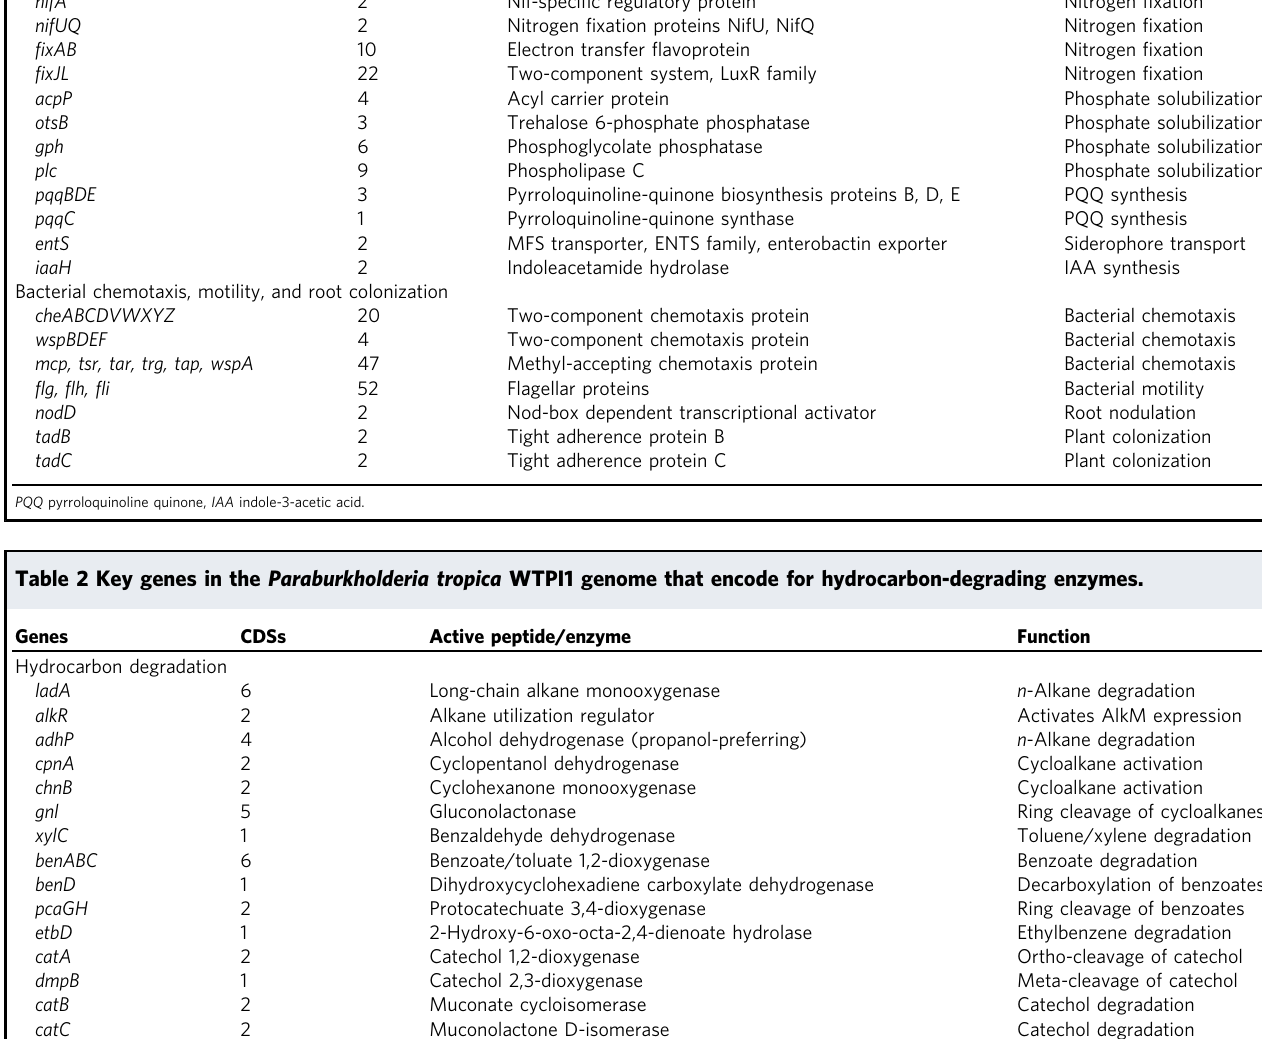
( p < 0.001) from that of the uninoculated plants (3.38 ± 0.07 g) (Fig. 1b). Statistical analysis of growth, in terms of mean shoot height per time, revealed that the inoculated M. sativa plants exhibited greater relative growth rate (0.109 ± 0.002 cm/day at the point of in fl ection) than the uninoculated plants (0.092 ± 0.004 cm/day) (Fig. 1c).